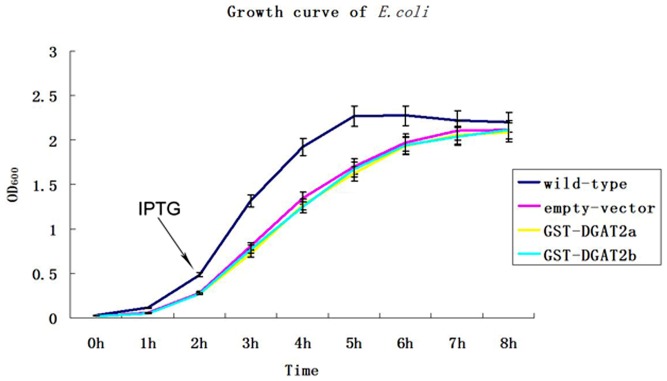
Growth curves of the wild type and transformed E. coli strains in liquid culture.The optical density (OD600) of the bacterial cultures is shown on the y axis. Bacteria were incubated aerobically at 37°C with shaking at 170 rpm. Vertical bars represent the standard deviation of three replicates.